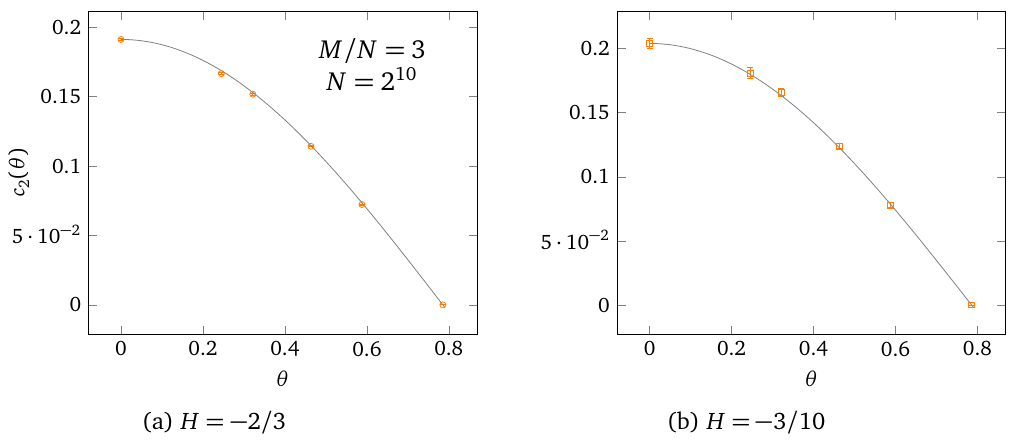
( θ ) from fit (33), for different angles θ , for H < − 1 / 2 (a) and Figure 11: Values of c 2 ( θ ) = c ( 0 ) cos ( 2 θ ) . H > − 1 / 2 (b). The curves show the prediction c 2 2 The behaviour of the order 6 coefficient is also in fair agreement with prediction (29), as shown in Figure